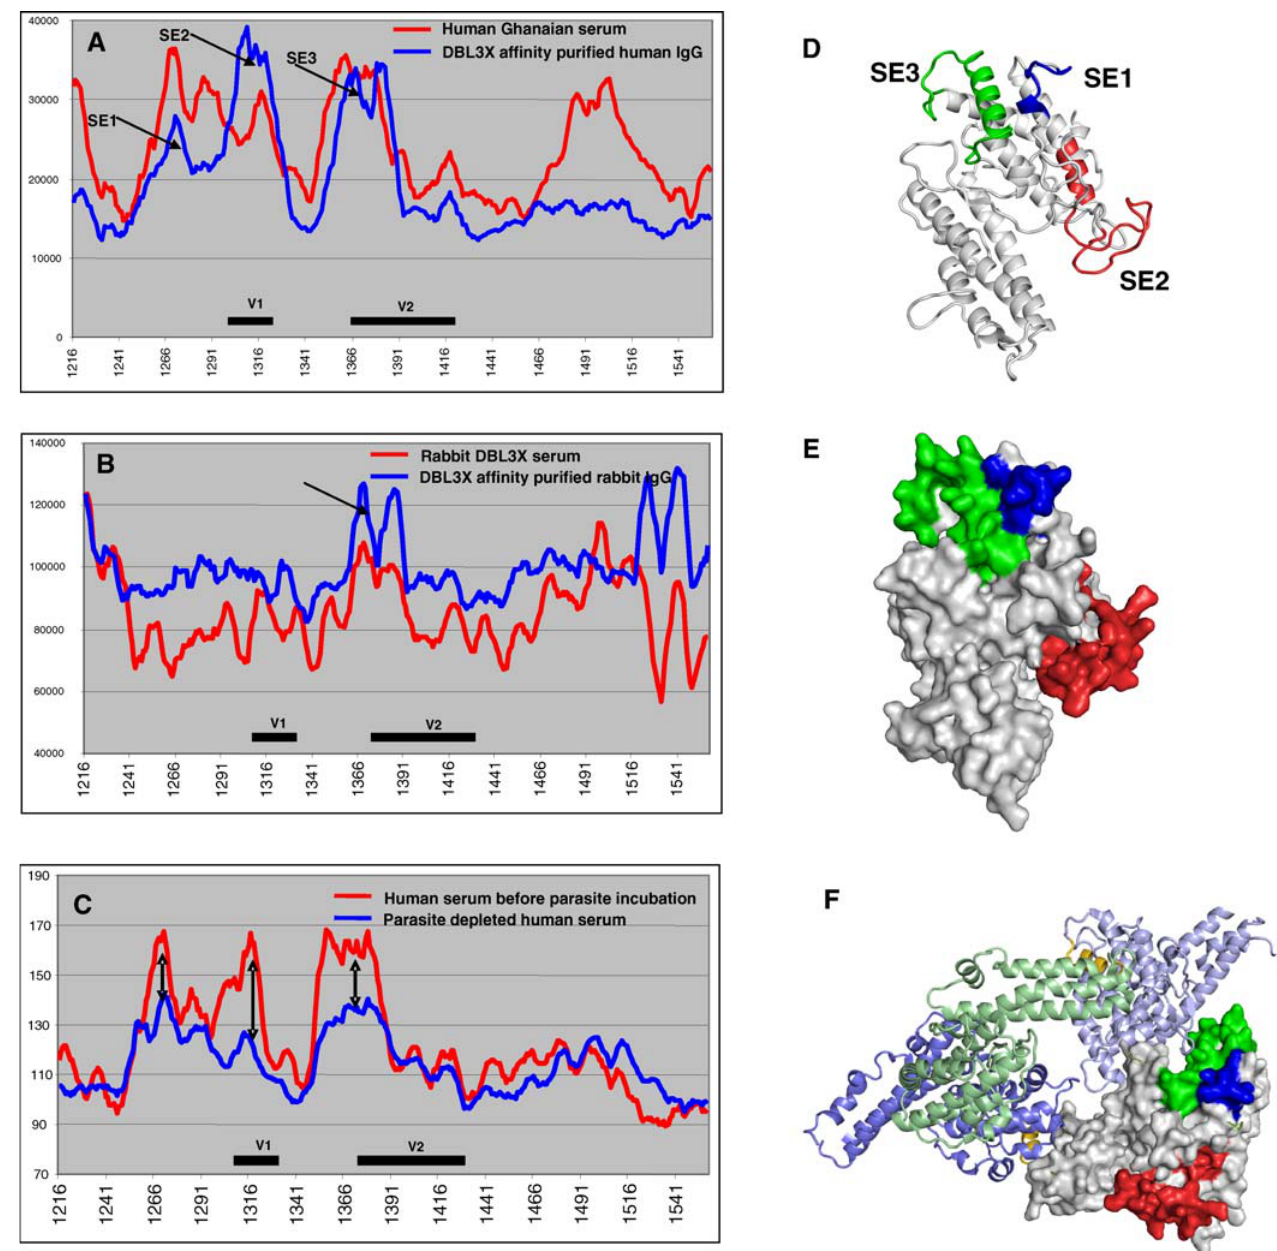
Figure 7. Reactivity of Plasma Affinity Purified on Recombinant DBL3X and Human IgG Depleted for Surface Reactivity by Incubation with Infected Erythrocytes Expressing VAR2CSA (A) PepScan IgG reactivity in a Ghanaian pool of pregnancy plasma before (red) and after (blue) affinity purification on recombinant DBL3X protein. Variable regions V1 and V2 are indicated with a black line. Arrows indicate three surface-exposed regions (SE). The x-axis is amino acid position in 3D7 VAR2CSA. (B) PepScan IgG reactivity in plasma from a rabbit immunized with DBL3X before (red) and after (blue) affinity purification on recombinant DBL3X protein. Arrow indicates the surface-exposed region. N- and C-terminal parts of the recombinant proteins did also appear to be surface-exposed; this could be due to improper folding of the N- and C-terminal parts of the protein. (C) PepScan IgG reactivity in a Tanzanian pool of pregnancy plasma before (red) and after (blue) depletion of antibodies directed against surfaced- exposed VAR2CSA regions by incubation with infected erythrocytes expressing VAR2CSA on the surface. Arrows indicate three regions where the reactivity was markedly reduced after depletion largely corresponding to SE1, SE2, and SE3 on (A). (D) DBL3X model showing the location of surface-exposed epitopes, SE1 (blue), SE2 (red), and SE3 (green). (E) DBL3X surface topography showing SE1–SE3. From the model it is apparent that the SE1 and SE3 form a continuous epitope. (F) VAR2CSA DBL3X superimposed on the F1 domain of one of the molecules in the EBA-175 dimer. The F1 domain is shown in green, F2 domains are blue, and the linker regions are gold. On the DBL3X domain the three experimentally verified surface-exposed regions are shown in similar coloring as (D and E) The three regions are mainly predicted to be on the opposite side of the central cavity of the dimer, and parts of SE3 correspond to amino acid positions directly involved in the dimerization of